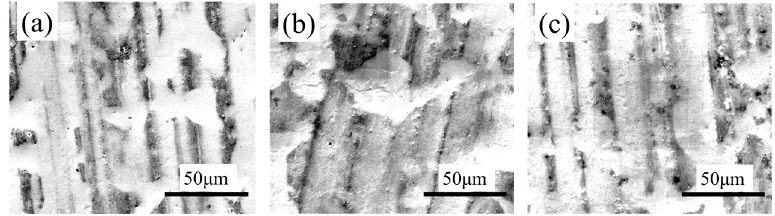
Figure 1. SEM images (2000×) of tinplate treated with ( a ) reflowing before passivation, ( b ) chemical passivation, and ( c ) electrolytic passivation.